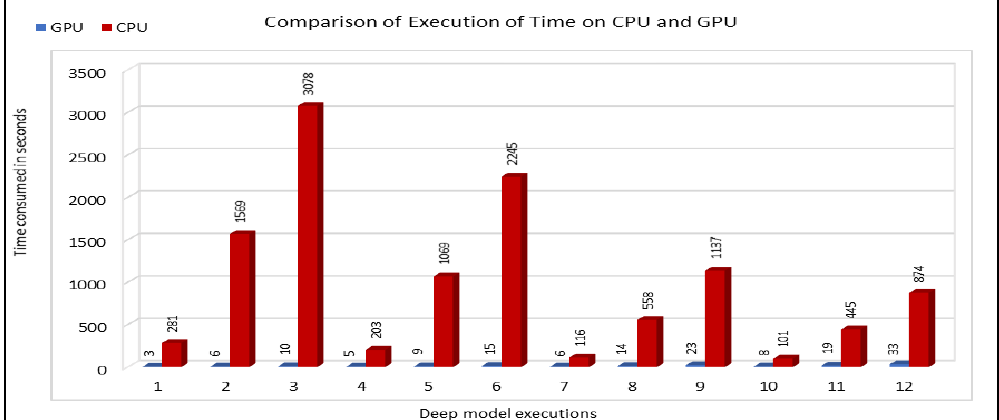
Figure 24. Comparison of deep model execution time on CPUs and